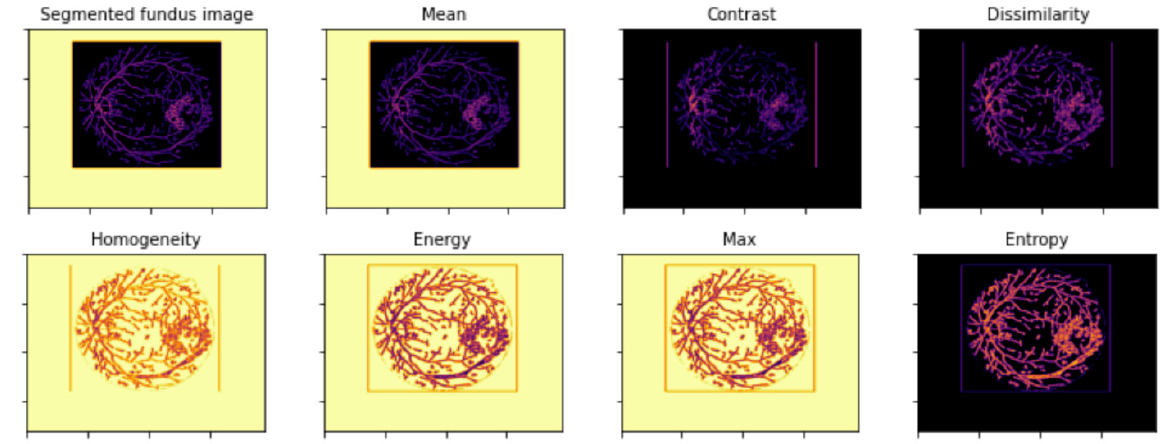
Figure 11. Visualization of GLCM features of a normal fundus sample.